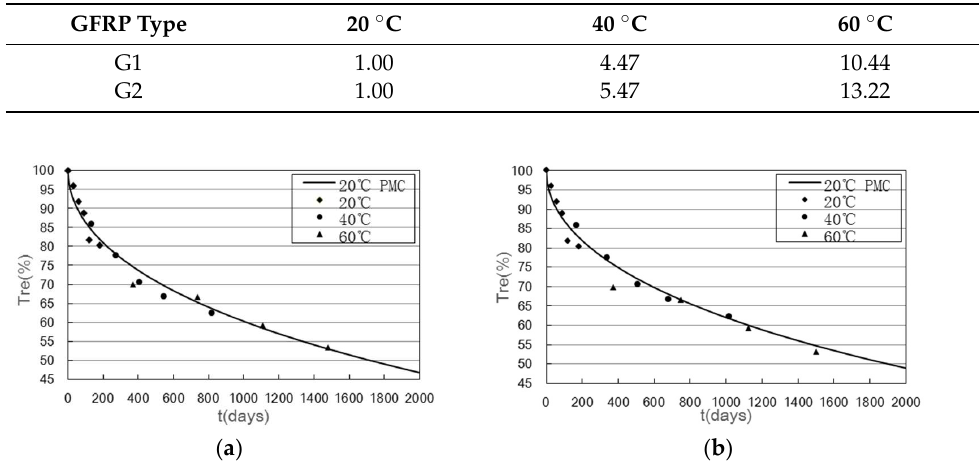
Table 13. TSF at temperatures of 20, 40, and 60 ◦ C based on the third prediction model.